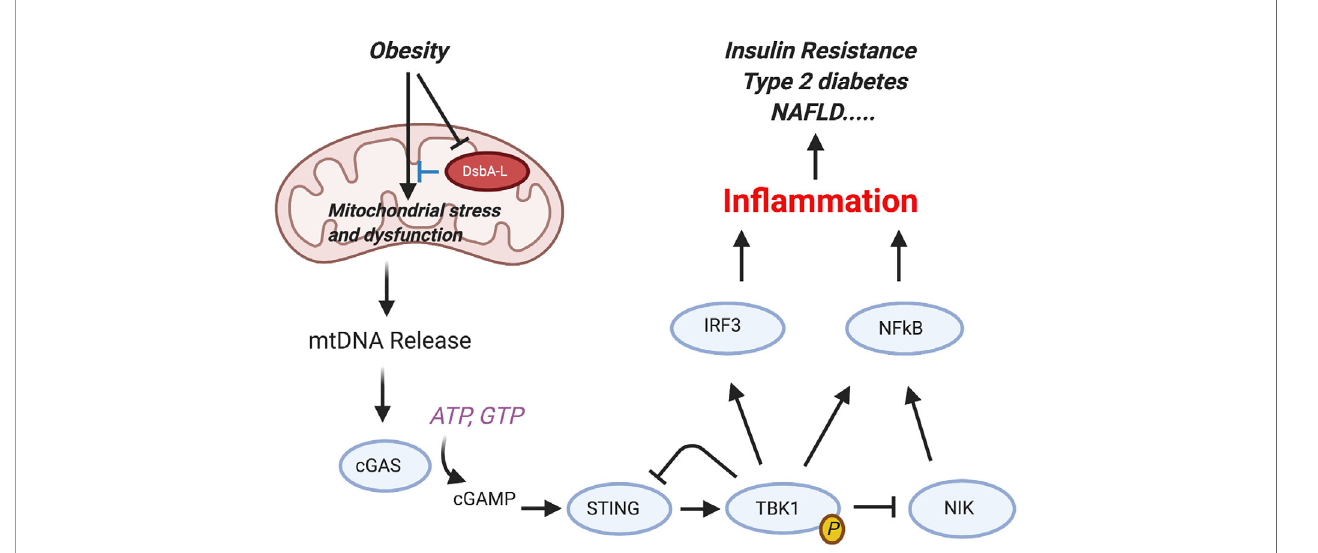
FIGURE 4 | Activation of the cGAS-cGAMP-STING pathway mediates obesity-induced in fl ammation and metabolic disorders. Obesity reduces the expression levels of disul fi de bond A oxidoreductase like protein (DsbA-L) in adipose tissue, leading to mitochondrial stress and subsequent mtDNA release into the cytosol. Aberrant localization of mtDNA in the cytosol activates the cGAS-cGAMPSTING pathway, leading to enhanced in fl ammatory gene expression and insulin resistance. Phosphorylated and activated TBK1 exerts a feedback inhibitory role by promoting STING ubiquitination and degradation or stimulating phosphorylation-dependent degradation of NF-kB – inducing kinase (NIK), thus attenuating cGAS-cGAMP STING – mediated in fl ammatory response [from Bai and Liu (80)]. Figure created with